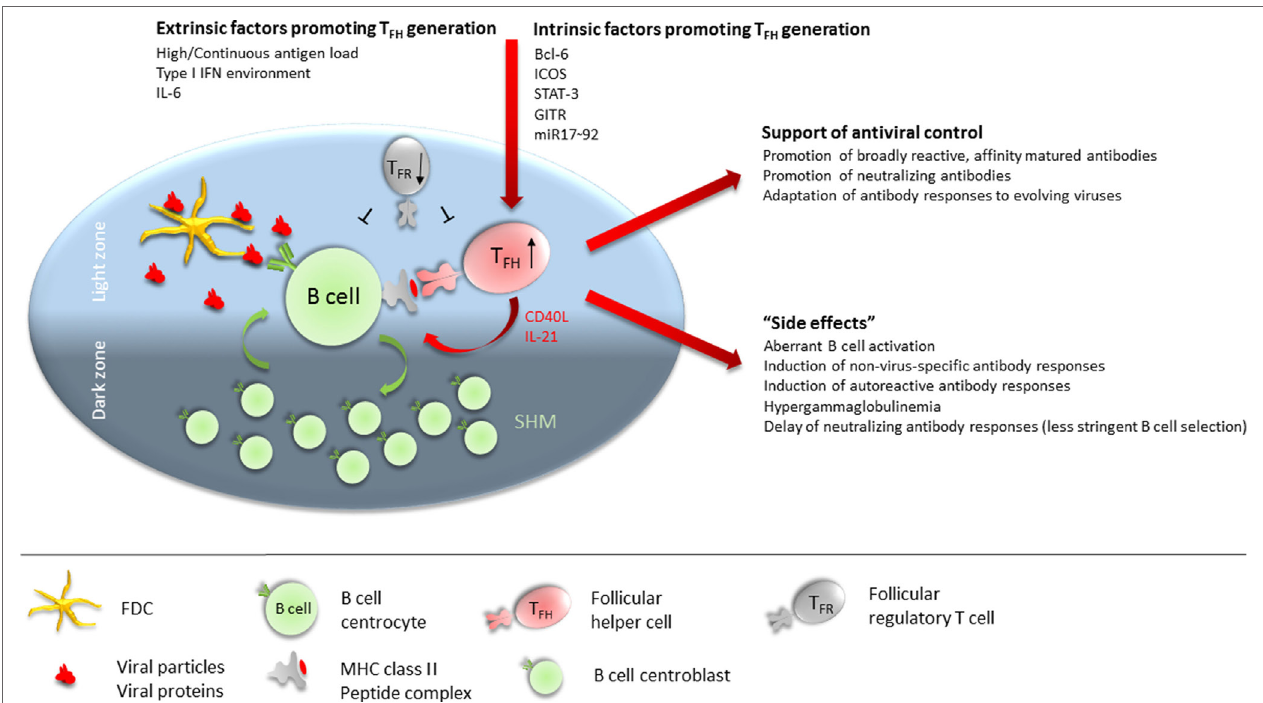
FigURe 1 | Follicular T helper (T FH ) cells at the cross-road of helping versus inhibiting. T FH numbers are numerically increased in many chronic viral infections. Extrinsic factors contributing to promote T FH differentiation during chronic viral infections include continuous high antigen load, sustained type 1 IFN environment, and IL-6 availability. Intrinsically, Bcl-6, ICOS, signal transducer and activator of transcription (STAT)-3, GITR, and miR17–92 expression in CD4 T cells is required for (efficient) T FH differentiation. In the germinal center (GC), T FH cells preferentially localize to the light zone (LZ) where they interact via their TCR with B cells presenting antigenic peptides on MHC class II. B cells acquire antigen from follicular dendritic cells (FDCs) in the LZ which serve as antigen depot. FDCs retain antigen in form of antibody– antigen complexes or opsonized antigen via Fc and complement receptors. Cognate interaction between B cells and T FH provides survival, proliferation, and differentiation signals to the B cell in form of CD40 engagement and IL-21 supply. B cells will then either differentiate into antibody-secreting plasmablasts and long-lived plasma cells, into memory B cells, or enter the GC dark zone where the proliferate and undergo somatic hypermutation of their antibody variable regions before re-entering the LZ for selection of high-affinity B cells clones. Sustained activity of T FH cells is required throughout chronic viral infection to promote broadly reactive, affinity matured, and neutralizing antibodies and to adapt antibody specificity to emerging viral variants. Conversely, the high numbers of T FH cells present during many chronic viral infections render the GC LZ B cell activation and selection process less stringent, leading to aberrant B cell activation, induction of non virus-specific antibodies (including autoantibodies), hypergammaglobulinemia, and delayed generation of neutralizing antibody responses. Further contributing to a dysregulated T FH /B cell interaction in GCs is a dysbalanced ratio of T FH :T FR cells, often with reduced numbers of follicular regulatory T (T FR ) cells in chronic viral